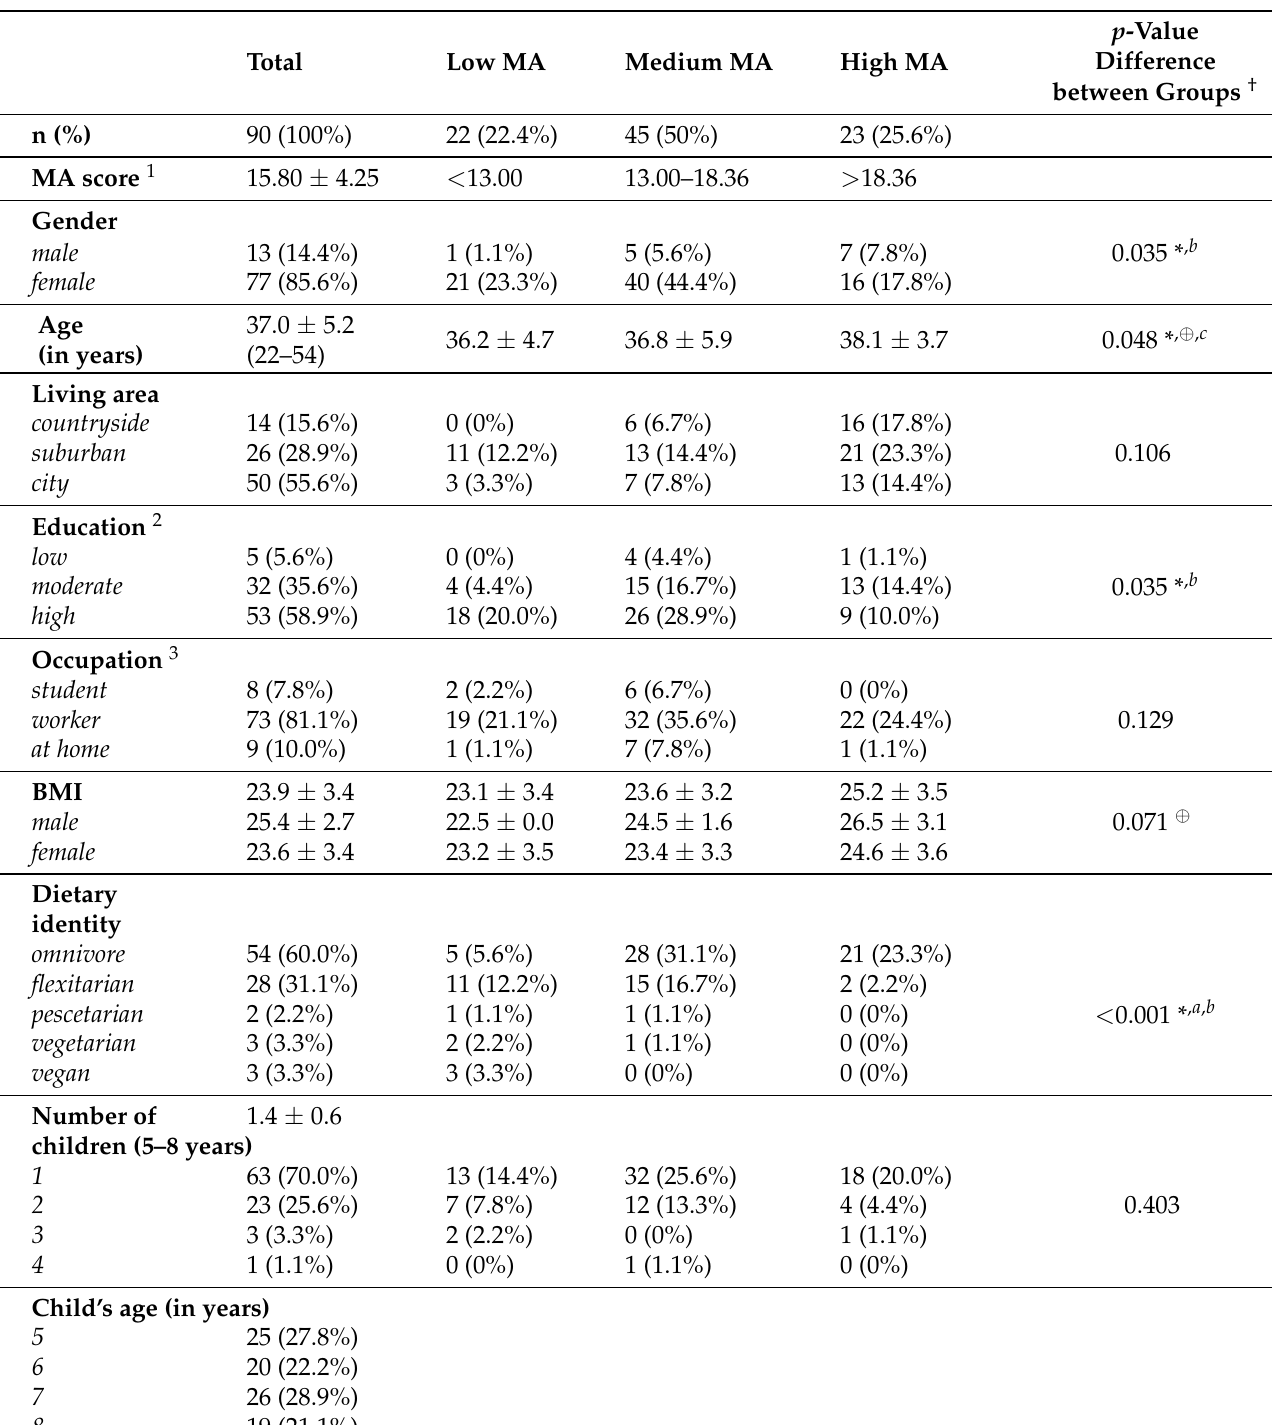
Table 1. Description of the total study population and the members of the groups low, medium and high meat attachment (MA). p -values show if the groups distinguish, statistical significant results are marked with a star. The corresponding post hoc test (pairwise test of independence) is given by a (low vs. medium MA), b (low vs. high MA), and c (medium vs. high